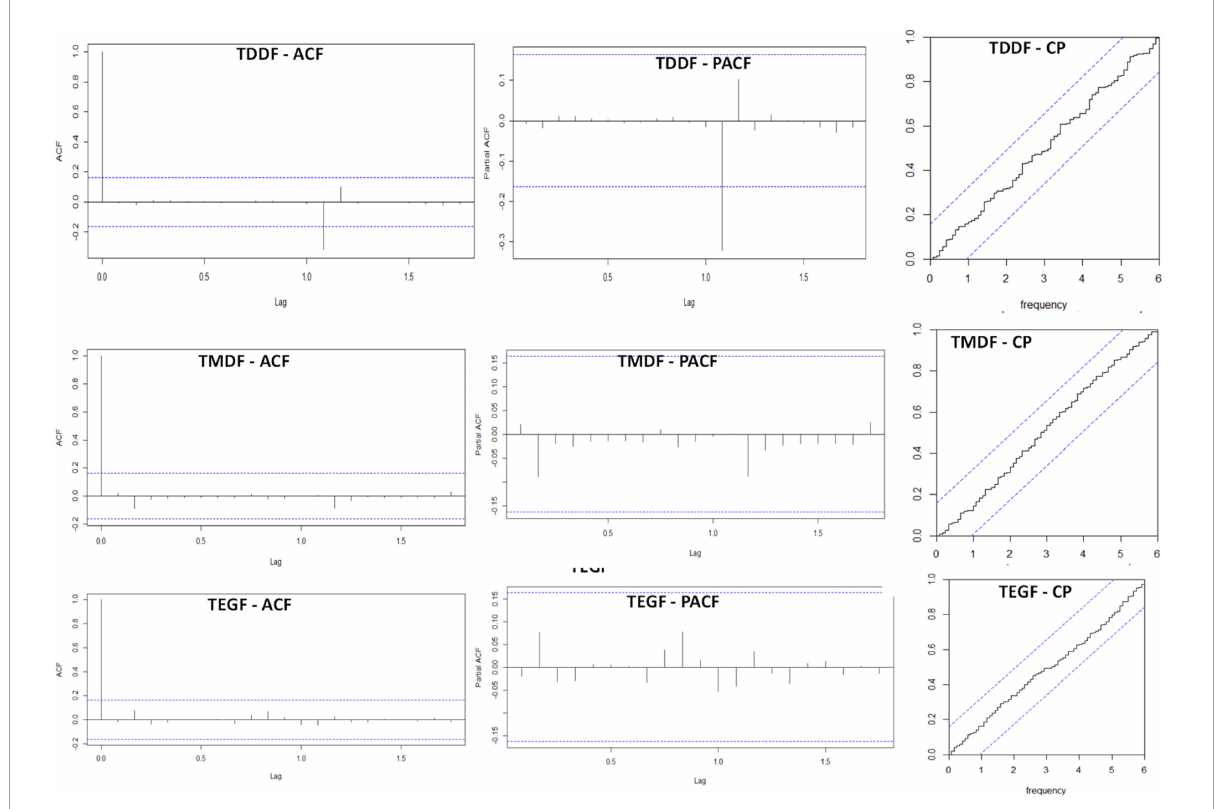
FIGURE5 Residual ACF (autocorrelation function); PACF (partial autocorrelation function; CP (cumulative periodogram for TDDF (Tropical Dry Deciduous Forests, TMDF (Tropical Moist Deciduous Forest and TEGF (Tropical Evergreen Forests) for univariate ARIMA